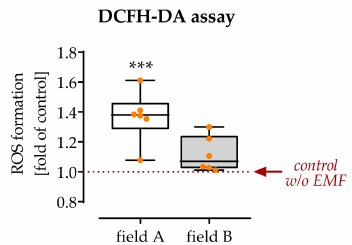
Figure 3. Intracellular ROS levels were regulated after single exposure to ELF-PEMFs. To detect intracellular reactive oxygen species (ROS), cells were incubated with a DCFH-DA probe before exposure to the ELF-PEMFs for 7 min. Produced ROS was quantified by the green fluorescence formed. N = 6, n = 3. Data were compared by non-parametric Kruskal–Wallis test, followed by Dunn’s multiple comparison test: *** p < 0.001 as compared to control cells without ELF-PEMF